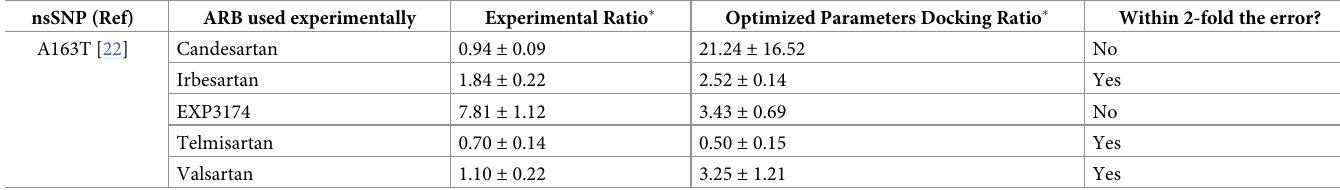
Table 4. Comparison of experimental and docking affinities to polymorphic AT 1